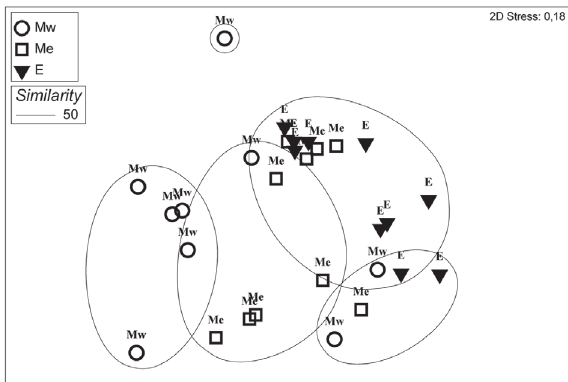
Fig . 5. − Mds plot representing differences in epibiosis assemblages on P. nobilis valves between stations. Table 4. − important taxa identified with siMPer analysis (Av.Ab, Average Abundance; Av.diss, Average dissimilarity). M e M vs. e species Av. Ab Av. diss sd